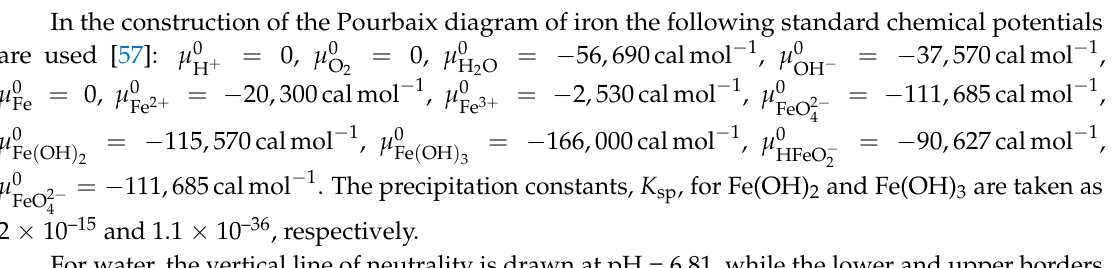
Figure 10. The potential-pH diagram for iron at 37 ◦ C and wet (hydrous) corrosion products. The lines for two concentrations (10 –6 M and 1 M) of soluble species are drawn.